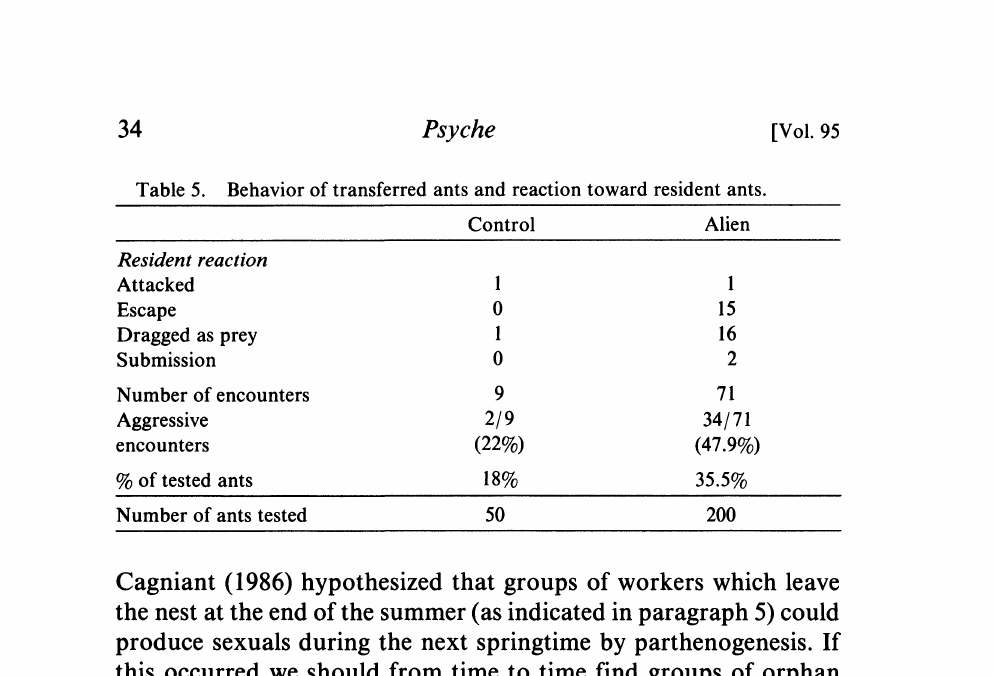
Table 5. Behavior of transferred ants and reaction toward resident ants.